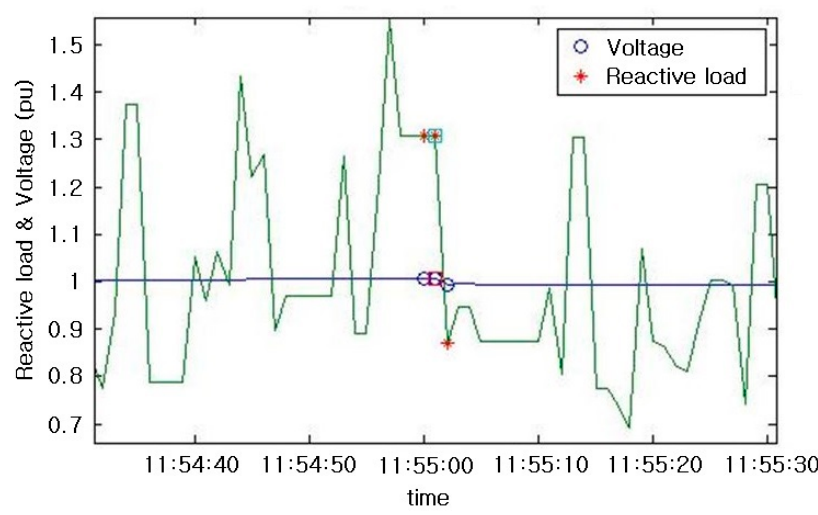
Figure 14. Voltages and loads of the Nowoon D/L.